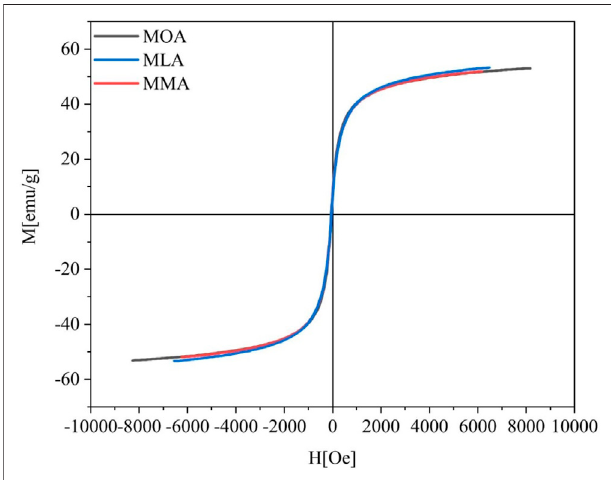
FIGURE 5 | Magnetization curve of particles in three magnetic fl